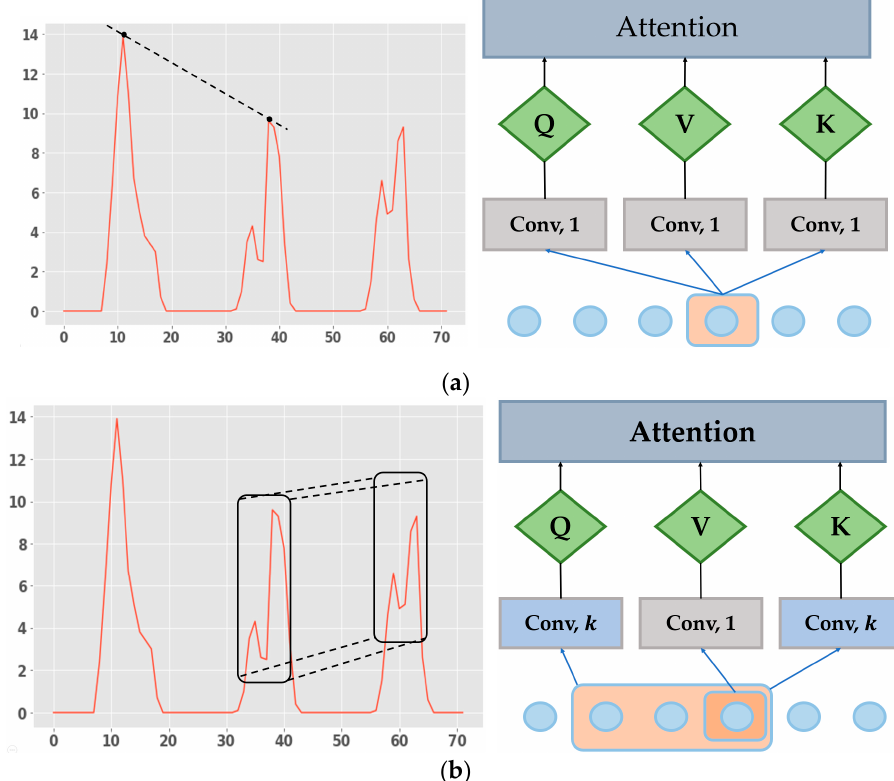
Figure 6. Comparison of canonical self-attention and convolutional self-attention techniques: ( a ) canonical self-attention; ( b ) convolutional self-attention, confirming the observation in [15], with slight variation.